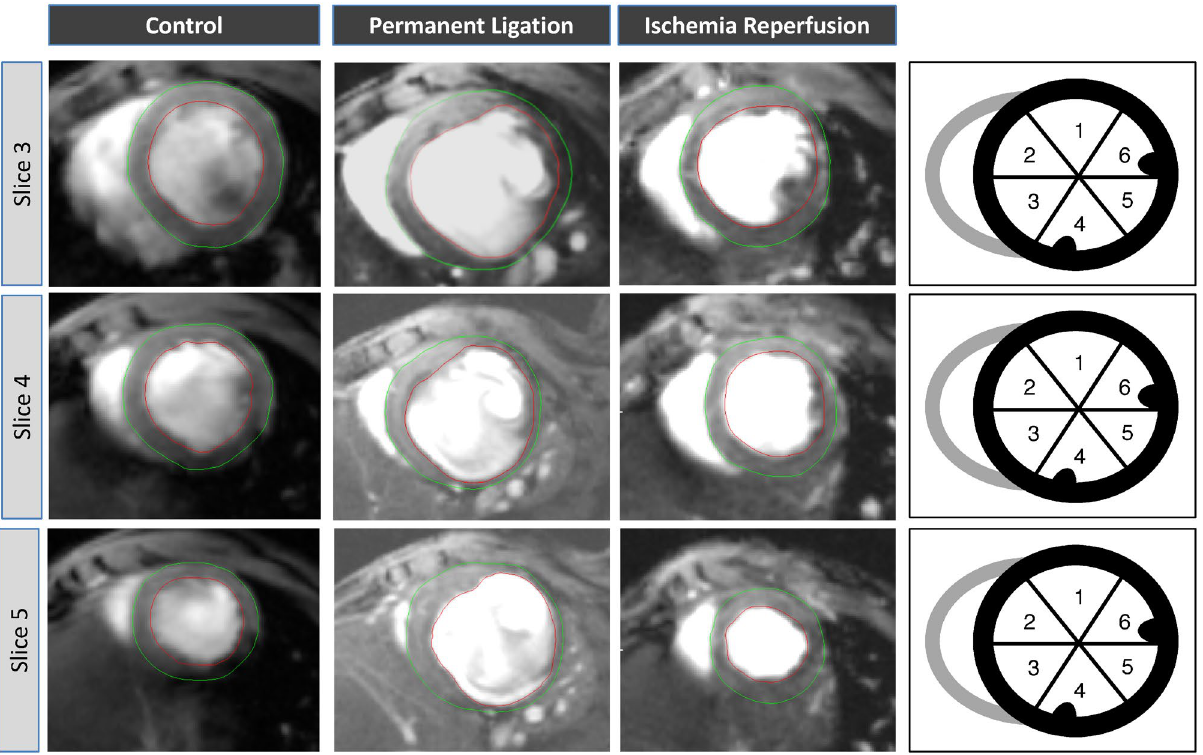
Figure 1. Multi plane assessment of the left ventricular wall. The left ventricle is covered by 5 short-axis slices from basal (1) to apical (5). The scar typically extended from slice 3–5. For regional wall analyses, slices 3–5 were divided into six segments. Septal wall: segment 2, 3. Lateral wall: segment 5,